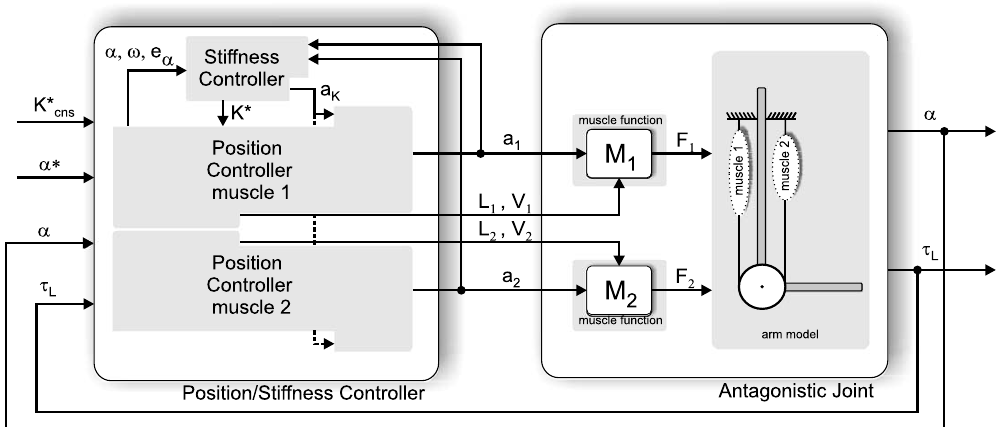
Fig. 4. Schematic view of the simultaneous Position/Stiffness Controller acting on the Antagonistic Joint . On the right side, two muscles ( M 1 and